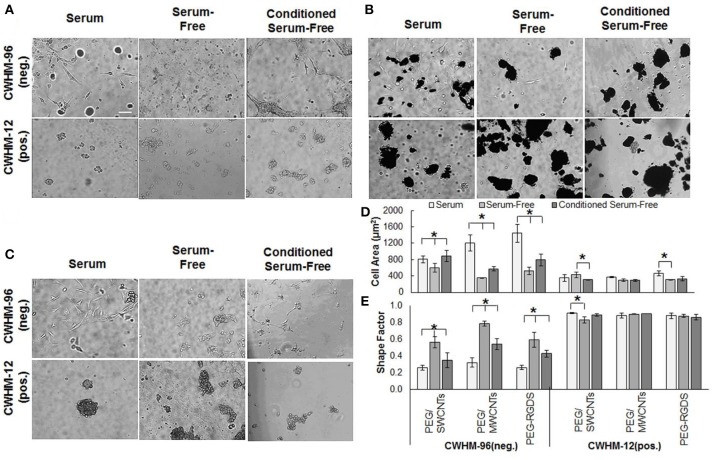
(A) Phase contrast images of NIH 3T3 cells in serum, (B) serum-free, (C) conditioned serum-free media on PEG/SWCNTs, PEG/MWCNTs, and PEG-RGDS hydrogels at 24 h after exposure to peptidomimetics (scale bar is 100 μm). (D) Cell area and (E) shape factor of NIH 3T3 cells on PEG/SWCNTs, PEG/MWCNTs and PEG-RGDS hydrogels in serum, serum-free and conditioned serum-free medium in the presence of CWHM-12 (active) and CWHM-96 (inactive control) peptidomimetics. *Asterisks designate significant differences (120 cells from n = 3, p < 0.05).